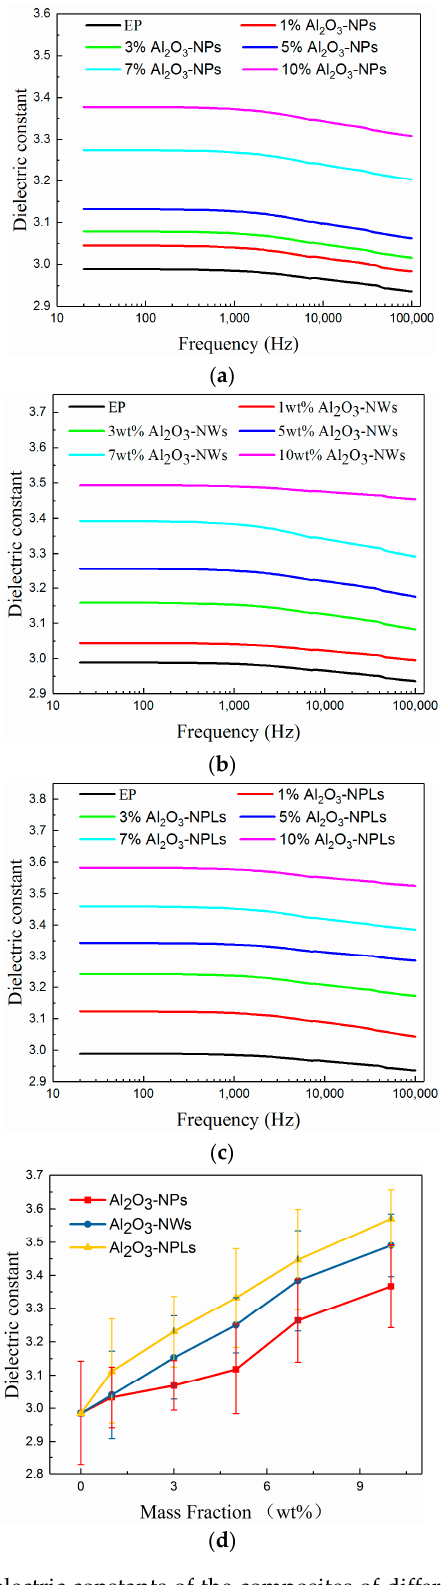
Figure 7. Change in the dielectric constants of the composites of di ff erent mass fractions of Al 2 O 3 nano-fillers with frequency: ( a ) Al 2 O 3 -NPs, ( b ) Al 2 O 3 -NWs, ( c ) Al 2 O 3 -NPLs, and ( d ) dielectric constants of the composites as a function of filler content measured at room temperature and 1